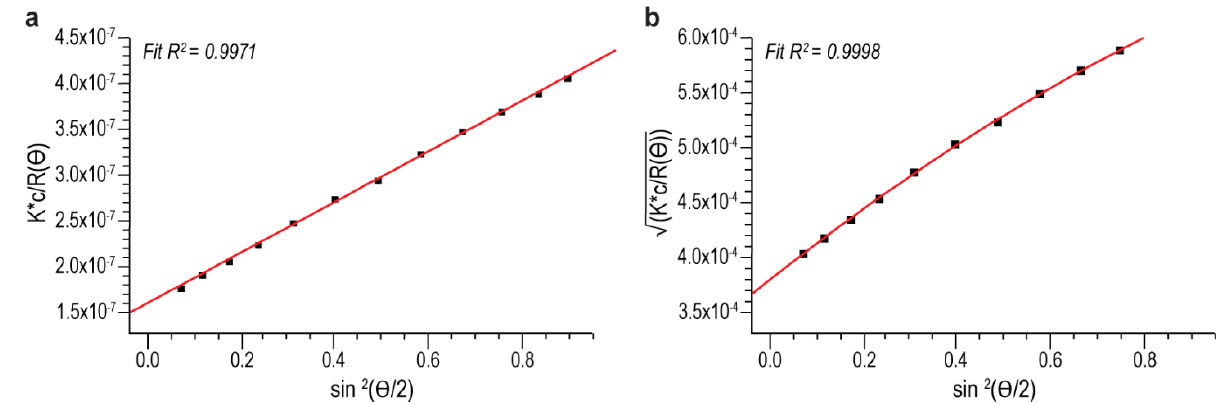
Figure 4. Zimm 1st order fit ( a ) vs. Berry 2nd order fit ( b ) for a ST-1 MVC on SEC-MALS. The red lines represent relationship between light scattering and angular function as described in Zimm and Berry formalisms. Table 3. MVC Mw comparison between Zimm and Berry fit models on SEC-MALS.